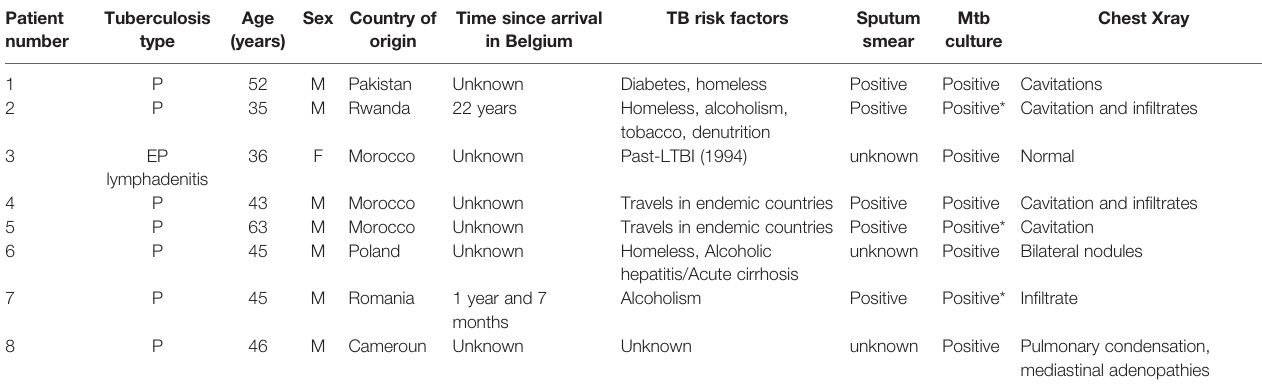
TABLE 3 | Demographic and clinical data of the misclassi fi ed aTB patients from the validation